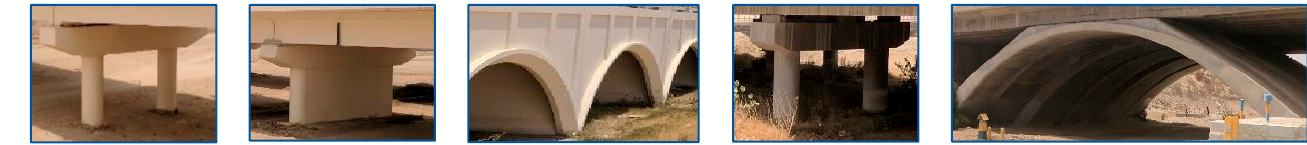
Figure 1. Substructural systems of reinforced concrete (RC) bridges.